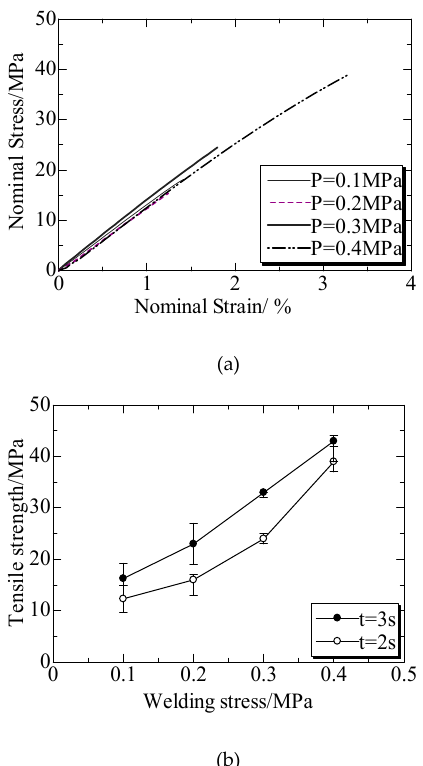
Figure 12. Welded strengths at different welding pressures. ( a ) Nominal stress and strain at different welding pressures under welding time of 2 s; ( b ) Welded strengths at di ff erent welding pressures under welding times of 2 s and 3 s. Adapted from Reference [149]. Polymers 2020 , 12 , x